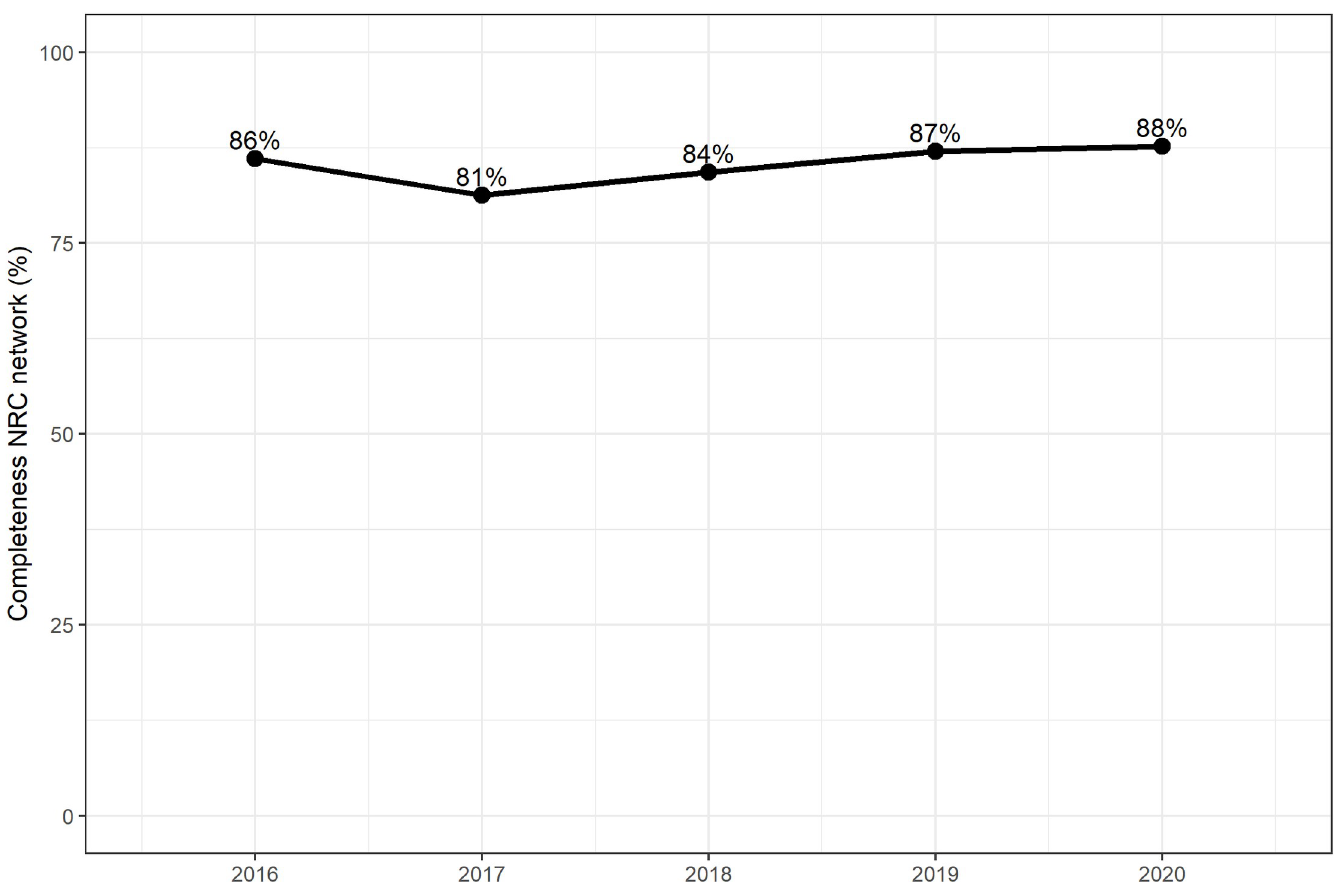
bers underlying the capture-recaptures analysis are presented in S5 Table.